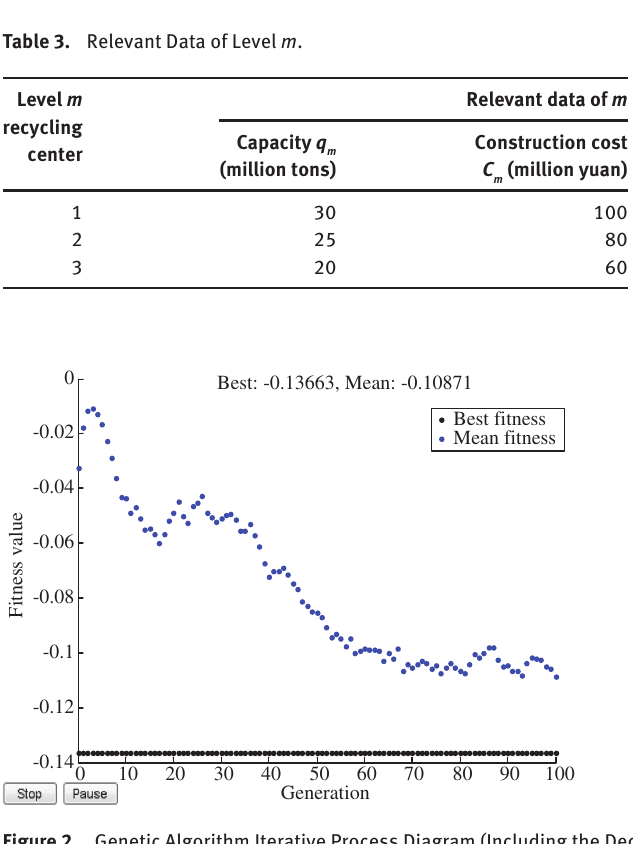
Figure 2. Genetic Algorithm Iterative Process Diagram (Including the Decision Variables Zr